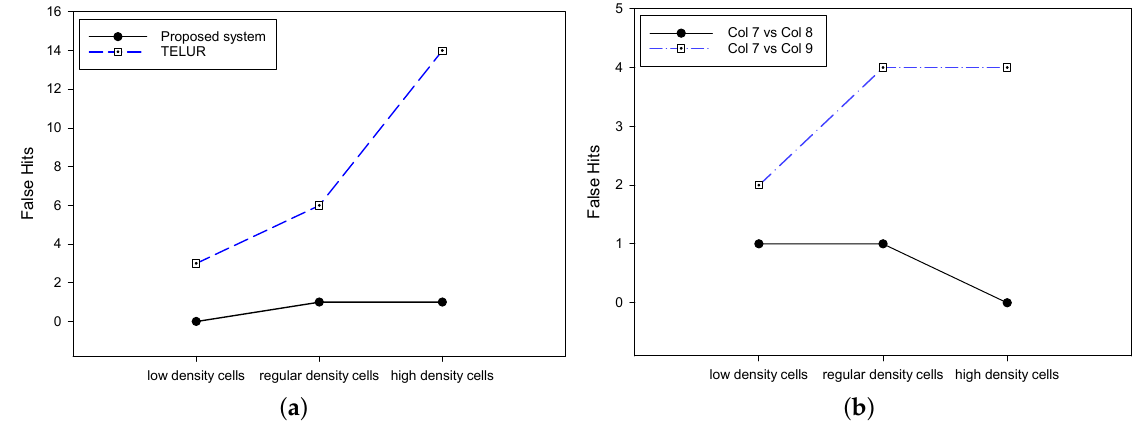
Figure 12. False hits for the path between two cells in the same building. ( a ) Same building and same floor; ( b ) same building and different floor.